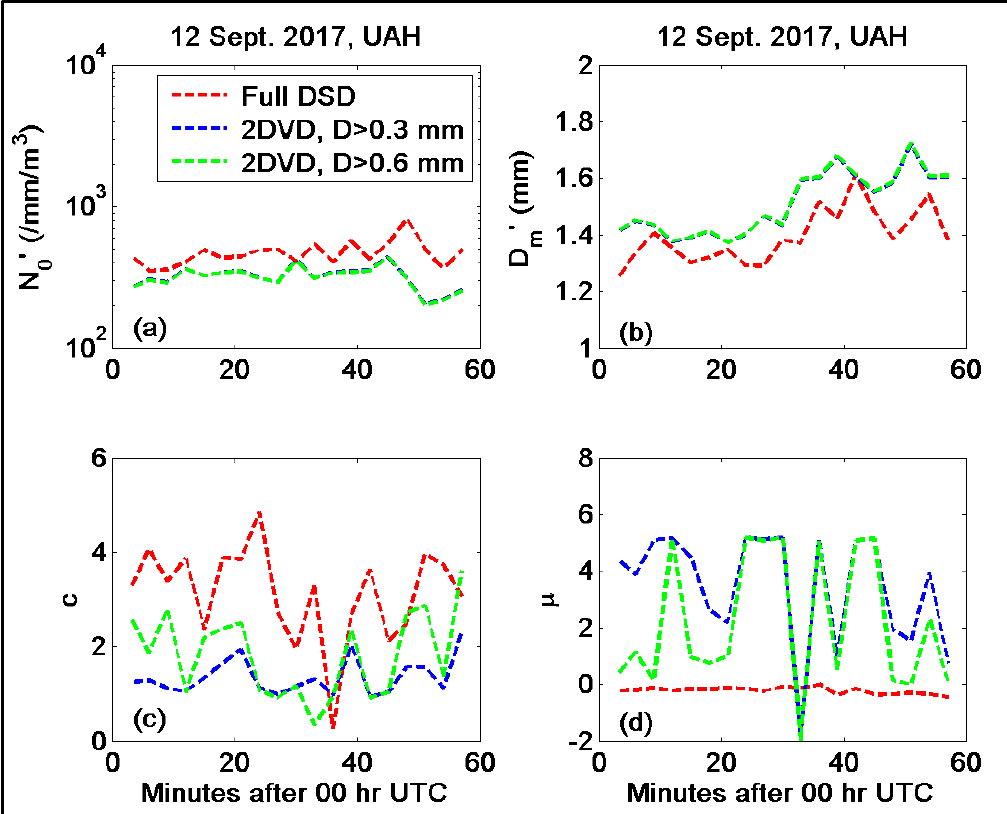
Figure 9 . ( a ) N 0 ’ derived from the full DSD spectra (red) compared with those using the 2DVD DSDs alone using data for D > 0.3 mm (blue) and for D > 0.6 mm (green); ( b ) the same as ( a ) but for D m ’; ( c ) the same as ( a ) but for the fitted c values; ( d ) the same as ( a ) but for the fitted µ values. The event corresponds to the outer bands of hurricane Irma on 12 September 2017, which traversed the ground instrumentation site in Huntsville.